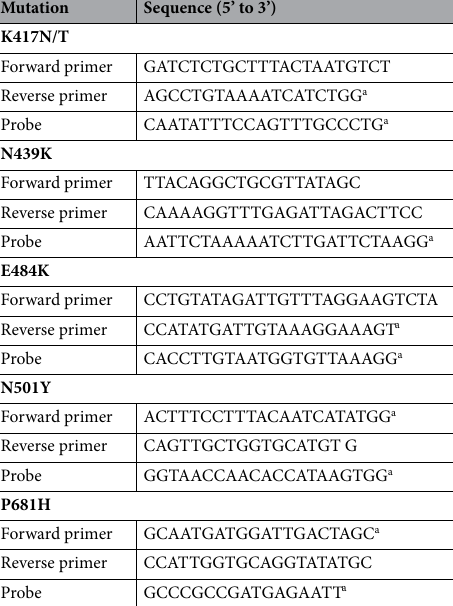
Table 1. 5 µL eluate from the BasePurifier was mixed with the RT-qPCR melting curve analysis assays con- taining 10 µL 2 × AmpliSmaRT One-Step RT-qPCR Master Mix (PentaBase A/S, Odense, Denmark) and 5 µL 4 × primer/probe mix. The RT-qPCR was performed using the following program: Reverse transcription 5 min at 52 °C, then a hot start polymerase activation at 95 °C for 30 s, followed by 45 cycles of 95 °C for 15 s and 60 °C for 45 s, followed by a continuous melting curve analysis: 95 °C for 1 min, 40 °C for 1 min, increasing the tem- perature up to 80 °C with 10 readings/°C for the BaseTyper and 2 readings/°C for the CFX96.